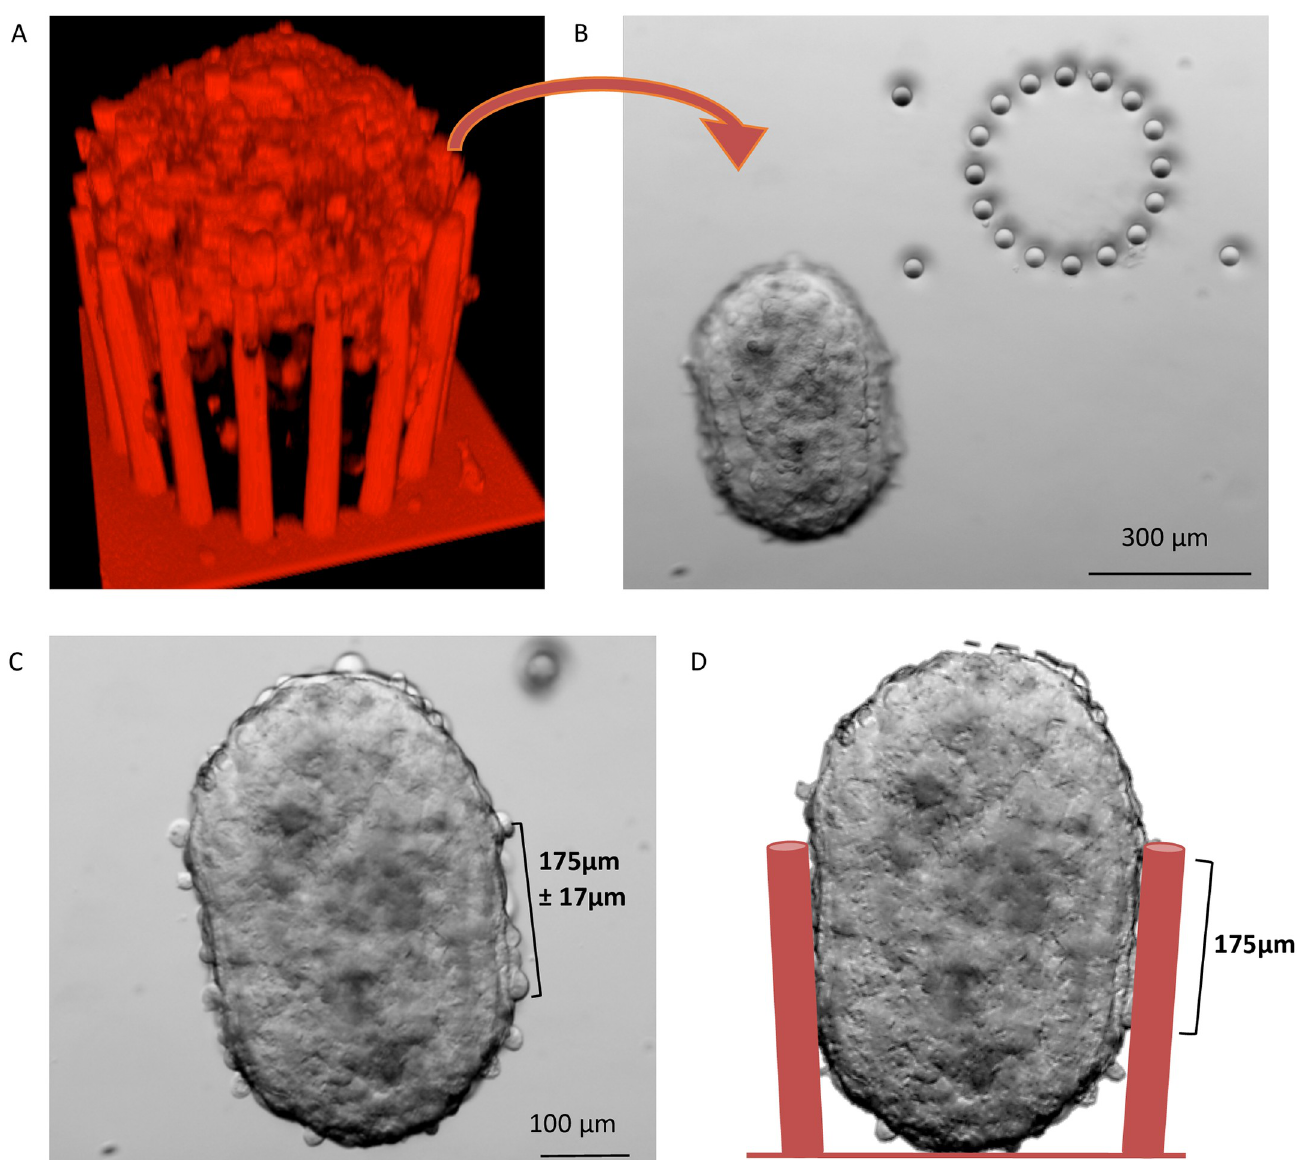
Fig 3. Determination of the spheroid-microdevice contact zone. (A) A 3D confocal image of a stained living spheroid in the microdevice showing the imaging limitations to access the whole spheroid. (B) Bright field microscopy image taken directly after the spheroid removal from the device showing the pillar imprints (arrowheads) on the spheroid. (C) Bright field image of the spheroid showing the round bottom and top and the very straight borders that define the contact zone, which was found to be 175 ± 17 μ m long. (D) Sketch of the spheroid in the microdevice showing the contact zone at day 4.